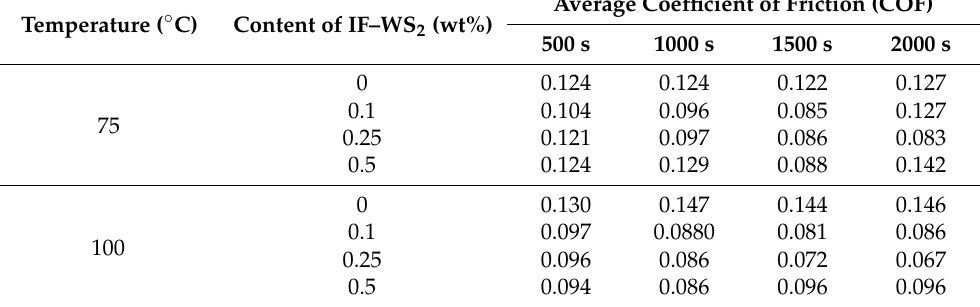
Table 1. Average COF values at different time.